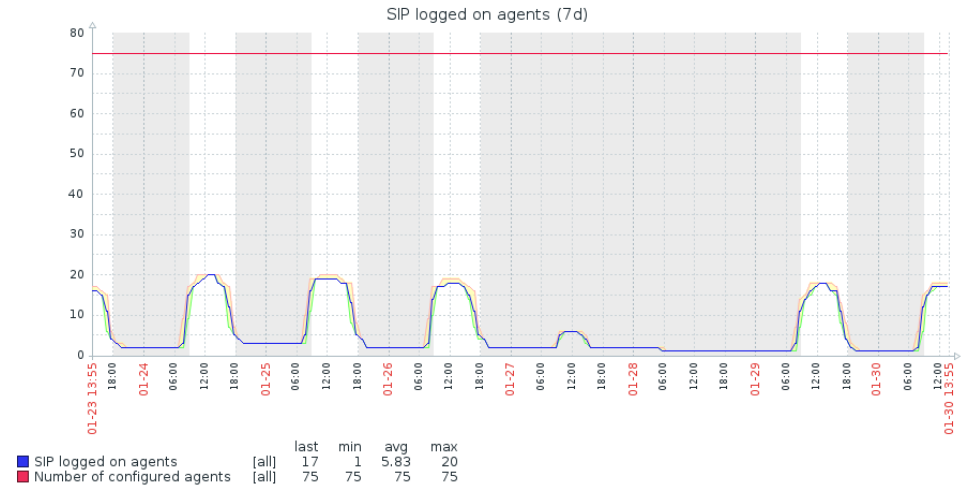
Figure 7. Monitoring statistics for user workload.